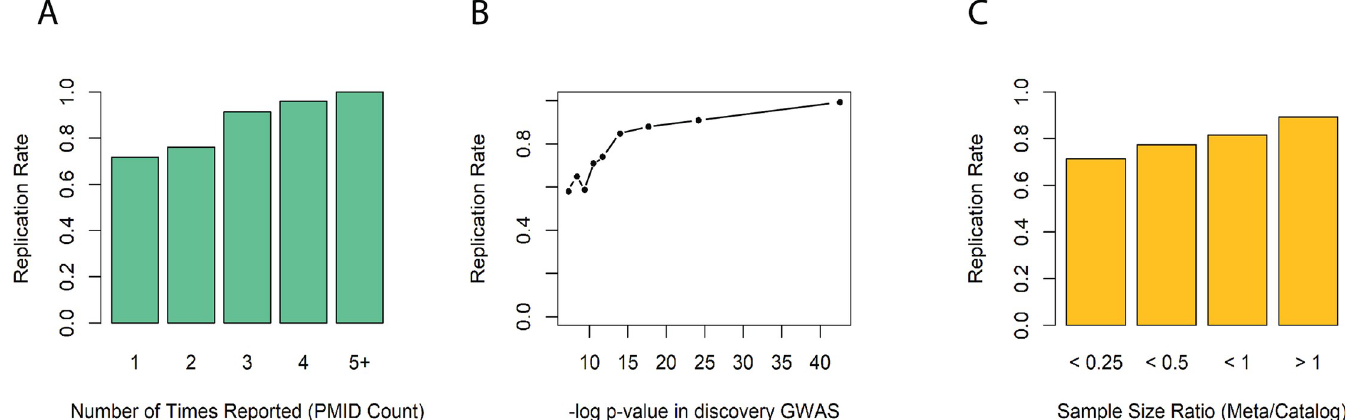
Fig 3. Replication rates for GWAS catalog SNPs of clinical labs increased with (A) the number of times an association was reported in the GWAS catalog, (B) the most significant p-value previously reported for the association, and (C) the ratio of sample size in our meta-analysis to that of the previous largest study.